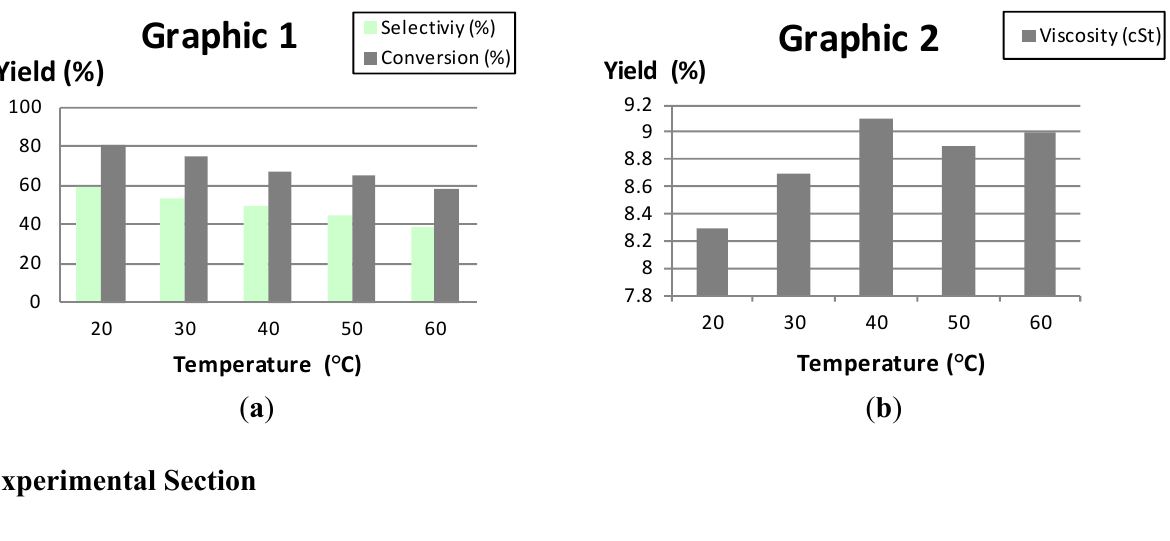
Figure 5. Influence of the temperature on ethanolysis reaction yield. ( a ) conversion, selectivity; and ( b ) kinematic